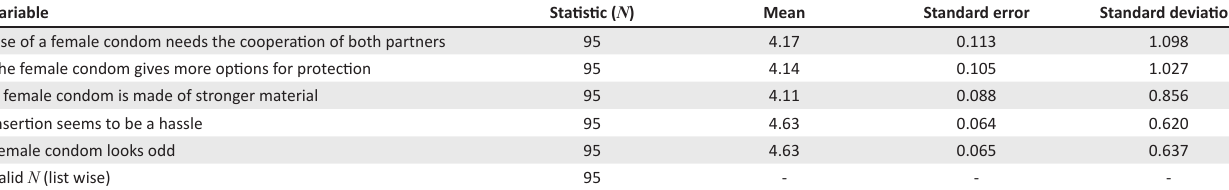
TABLE 4: Relationship between method of contraception and general views regarding female condom. Item Pearson’s c 2 value df Asymptotic significance (two-sided) Use of a female condom needs the cooperation of both partners.